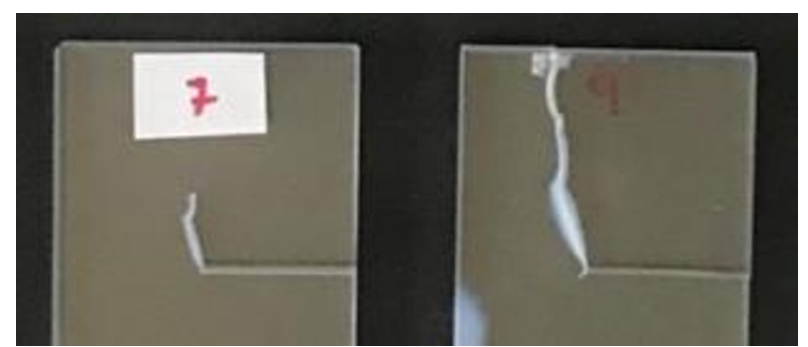
Fig. 2. Experimental results after impact velocity of 25m/s (left) and 30m/s (right). Evidence of crack arrest inside the plate. After [5]